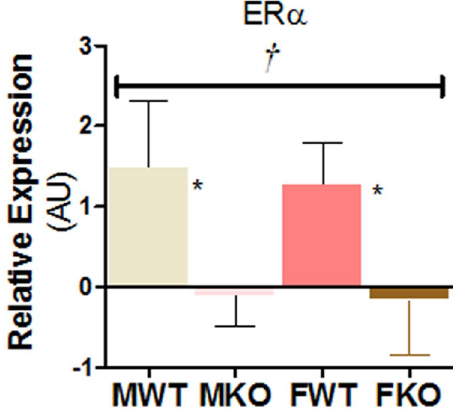
Figure 1. Extent of ER a knockout in the cardiac tissue: RNA from N=3/group mice were isolated and expression analyzed using primetime assay primers from IDT DNA (Iowa). { represents genotype significance, Two-Way ANOVA and * indicates significant difference within sex (Contrast Analysis by Tumhane and Dunlop Method [37]). P , 0.05 was considered significant for